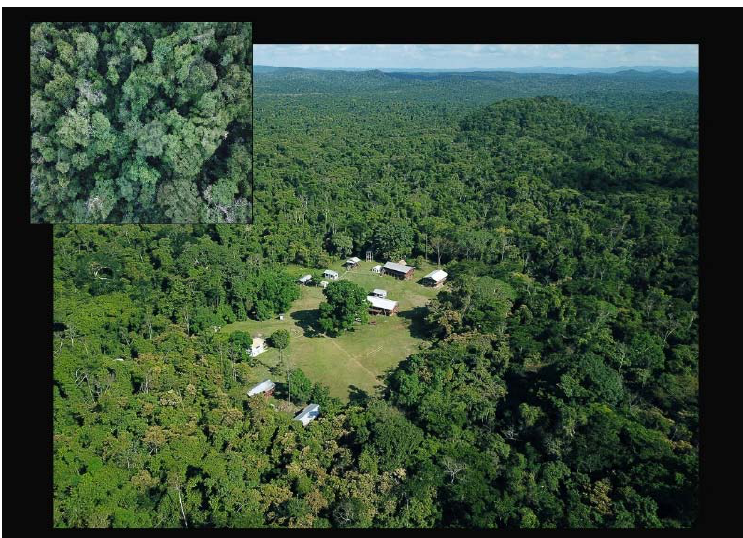
Figure 3. Regional map of Vaca Plateau illustrating location of Las Cuevas site and lidar coverage.